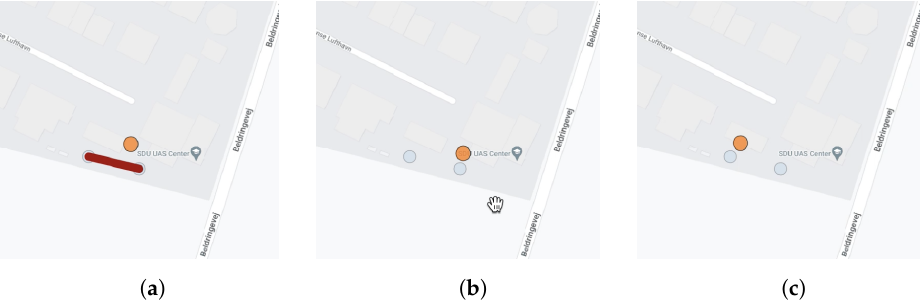
Figure 21. Mission planning, execution, and monitoring are visualized on the web interface. ( a ) mis- sion planning; ( b ) mission beginning; ( c ) mission